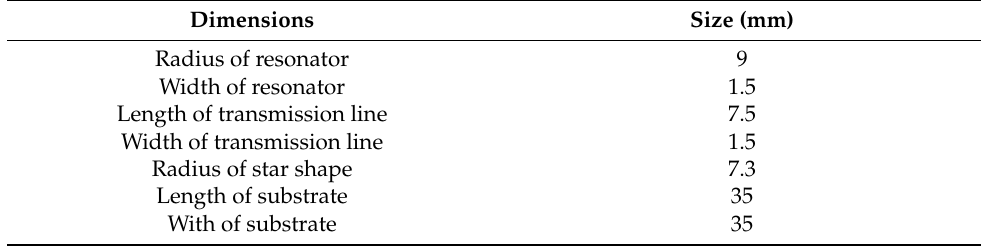
Figure 1. ( a ) Front view of the proposed metamaterials based on a corona shape and ( b ) its prospec- tive view. Table 1. Dimensions of the proposed